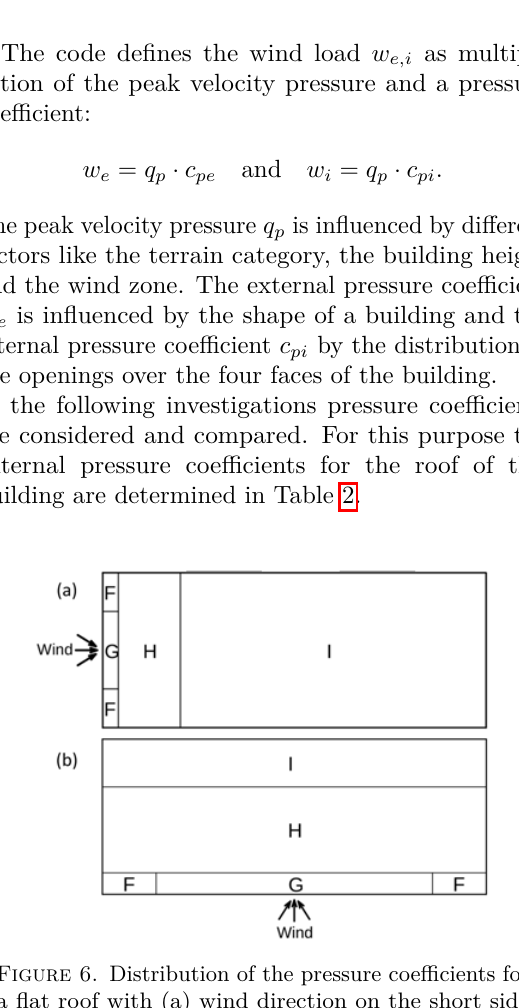
Figure 5. Three typical cases for the internal pressure ( Cook [6], modified).